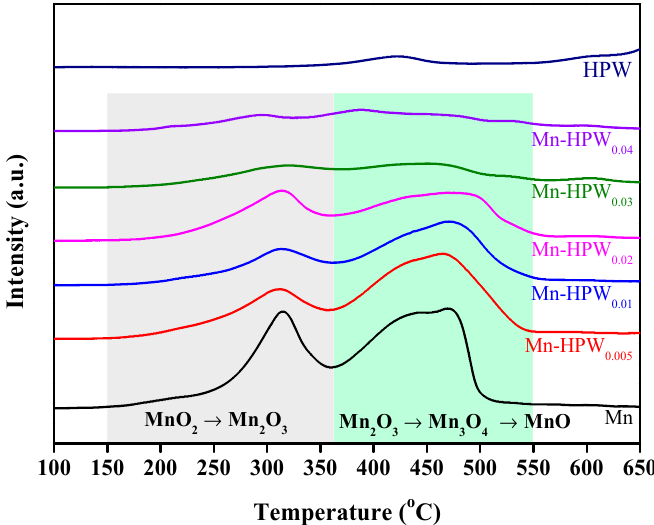
Figure 7. H 2 -TPR profiles of Mn, Mn-HPW x , and HPW.